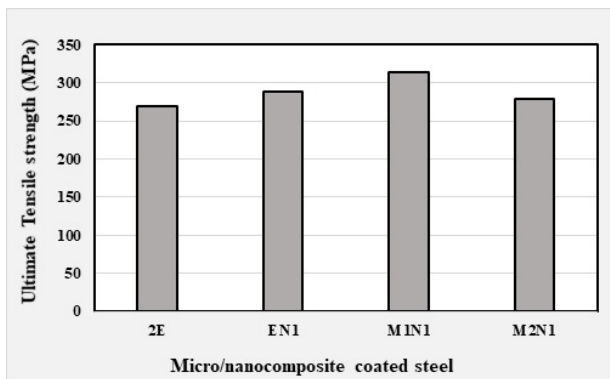
O micro/nanoparticles. 2 3